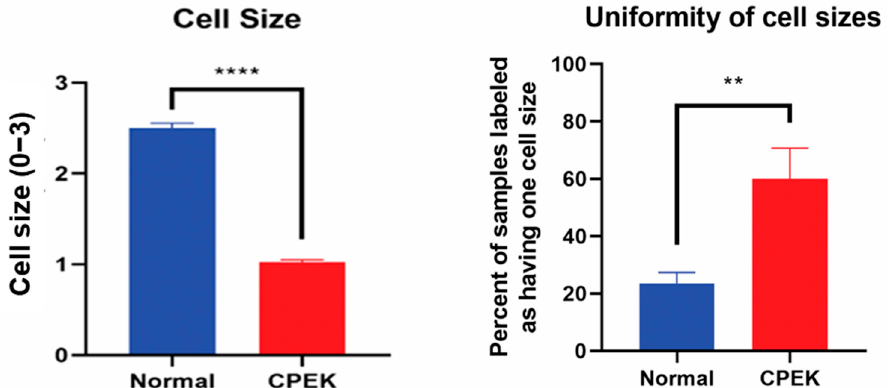
Figure 5. On the left, cell sizes in normal primary keratinocytes (Normal) vs. canine progenitor epidermal keratinocyte (CPEK) cells. Cell size was scored for size (1 = small, 2 = medium and 3 = large). Each observer evaluated 40 images for size and uniformity in a randomized fashion and being blinded to the source of the images. Observers labeled CPEK cells as having smaller cell sizes than normal. CPEK cell were shown to be significantly smaller using welch unequal variance t -test with a p -value of <0.0001. On the right, graph showing the variability of cell sizes between normal vs. canine progenitor epidermal keratinocyte (CPEK) cells. CPEK cells were shown to have a more uniform cell size across the sample (Observers labeled 60% of CPEK samples to have only once cell size present), while normal cells had a higher variability of cell sizes (Observers labeled 23.5% of normal cells to only have one cell size present). This difference was significant with a p value of 0.0078 using welch unequal variance t -test. **** indicates a significance p less than <0.0001 while ** indicates a significance of p higher than